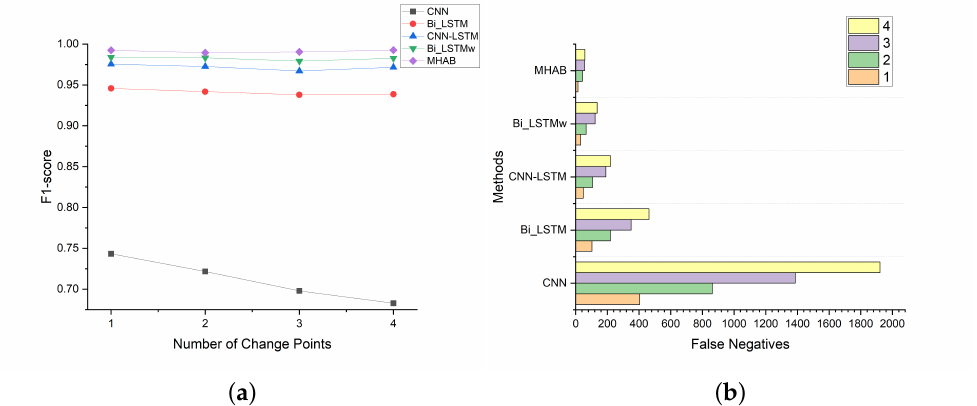
Figure 10. The effectiveness of change point numbers; ( a ) Result presented by F1-score; ( b ) Result presented by